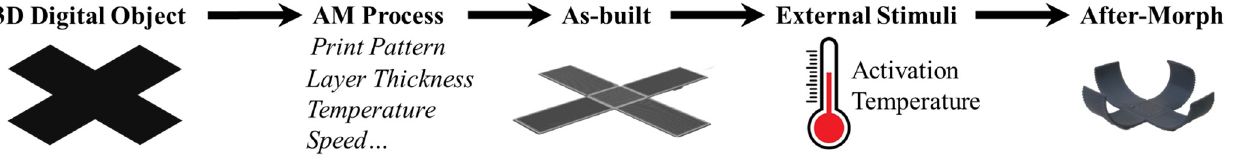
Figure 2. Thermo-responsive Self-morphing Design-Product Overall Workflow.